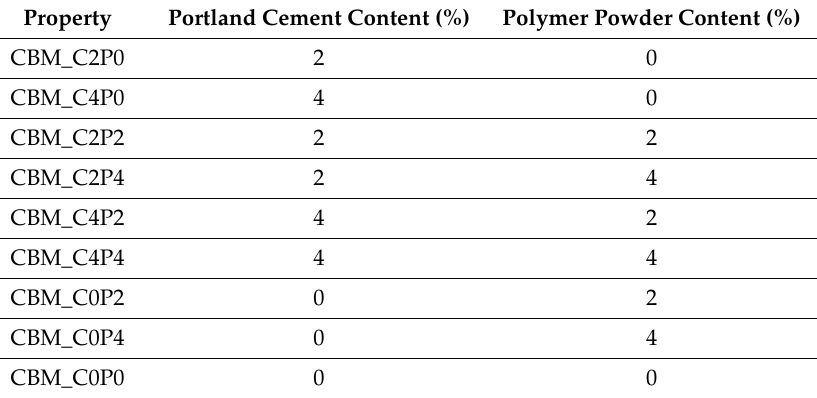
Table 7. Design of Table 7. Design of experiment.